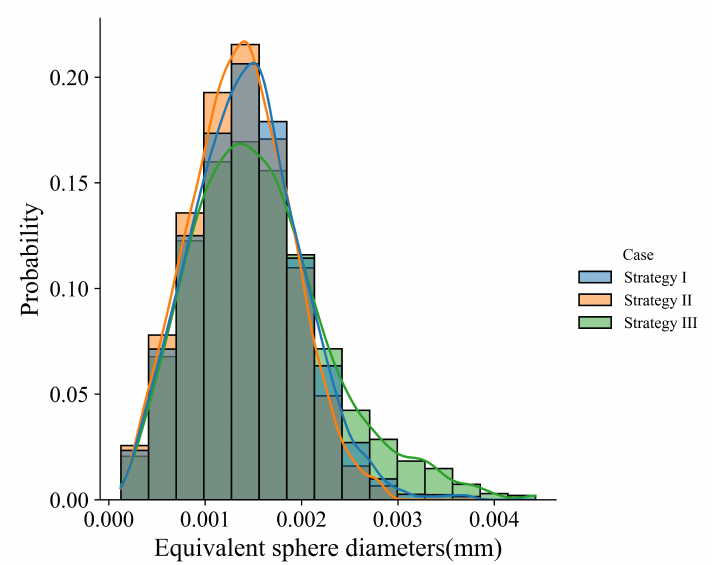
Figure 21. Grain size distribution of the simulation results in the first layer, first two layers, and three- layer microstructure.